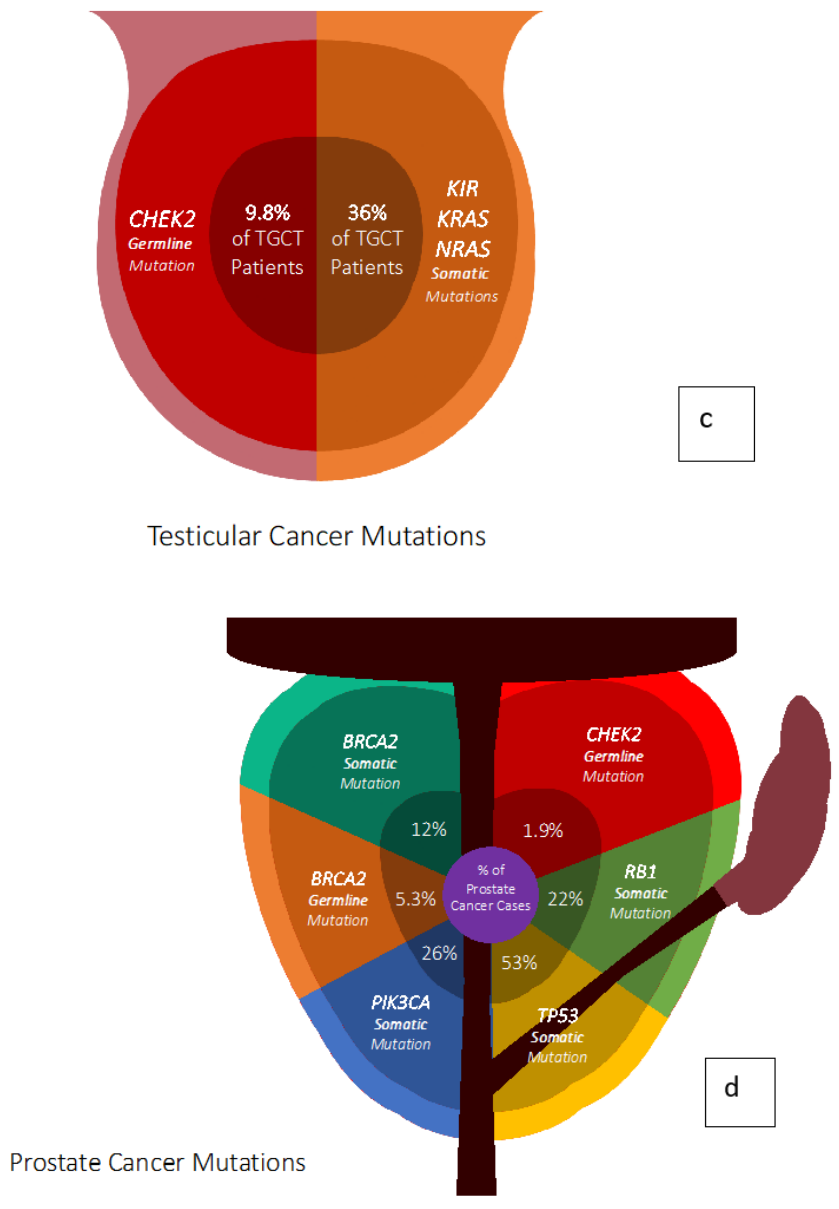
Figure 1. Germline and Somatic mutations found across tumor types. ( a ) Kidney Cancer Mutations, ( b ) Bladder Cancer Mutations, ( c ) Testicular Cancer Mutations, ( d ) Prostate Cancer Mutations.